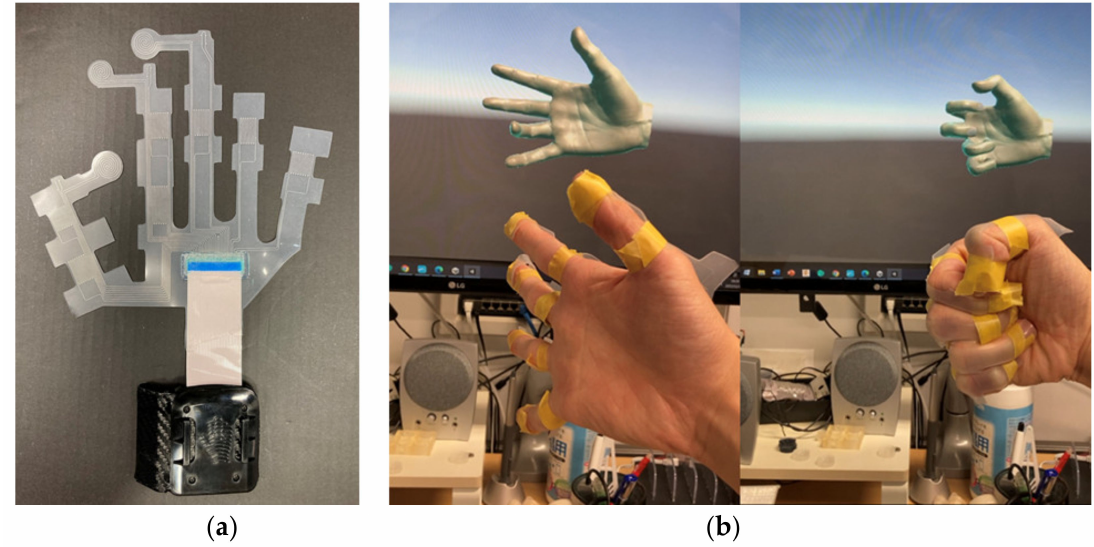
Figure 7. The custom-made angle sensDor: ( a ) prototype sensor; ( b ) gesture recognition of